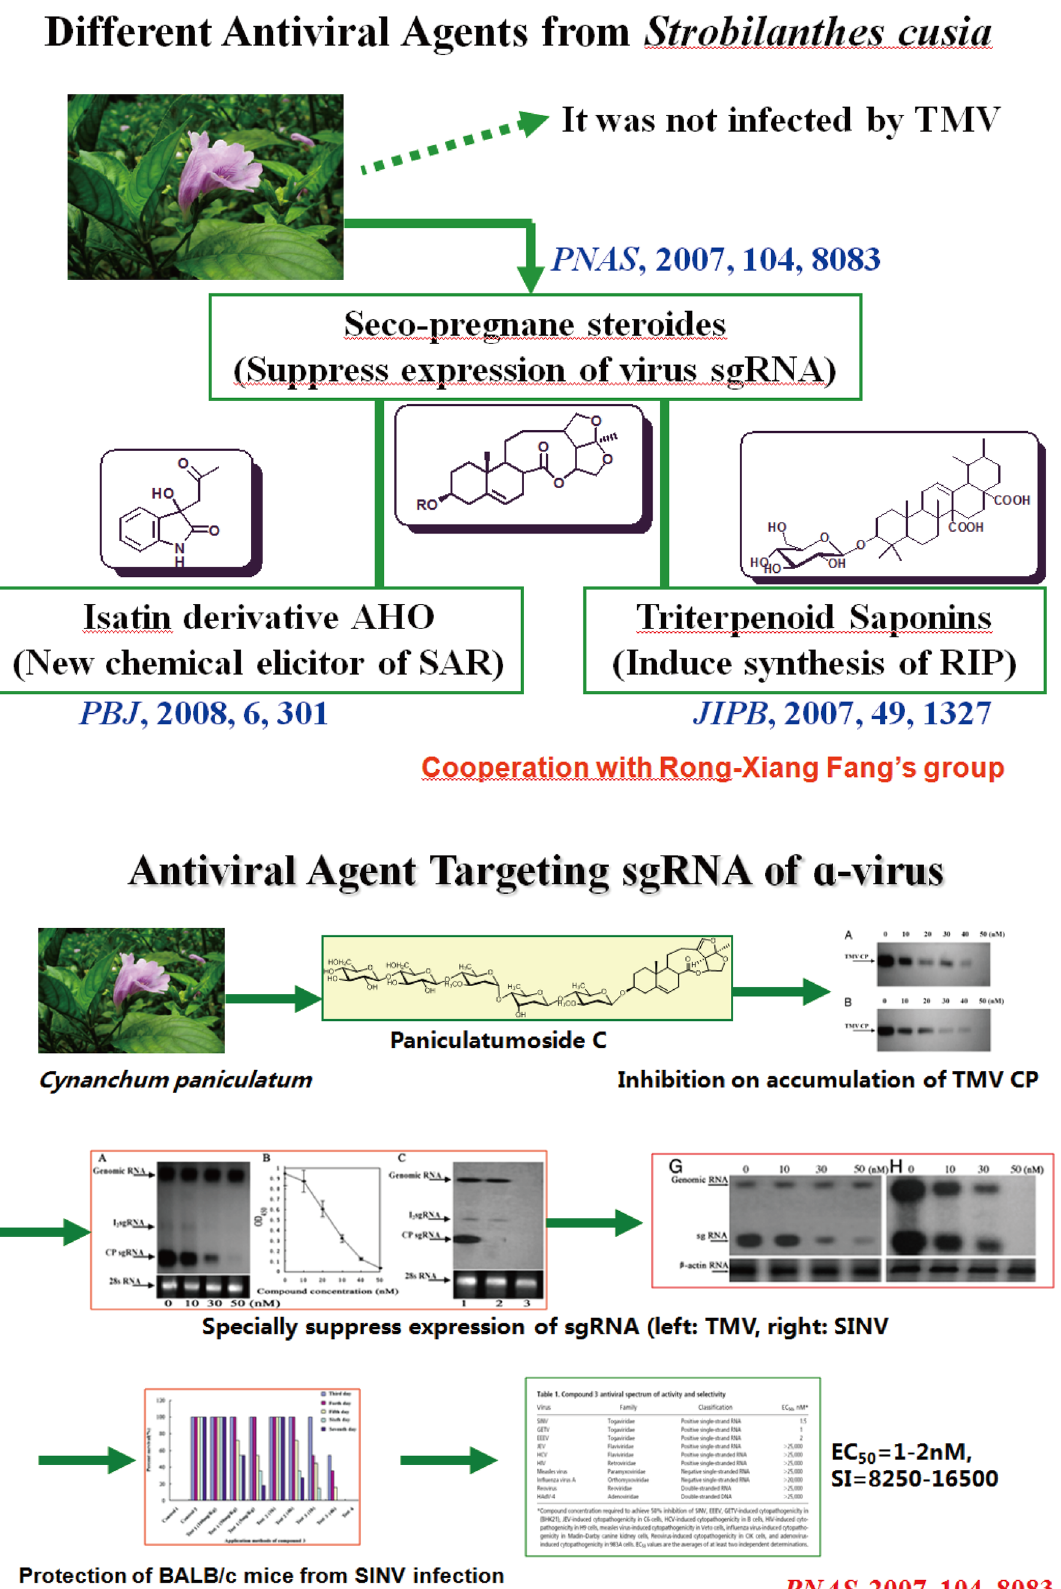
Fig. 3 Studies on low-toxic plant chemical defense